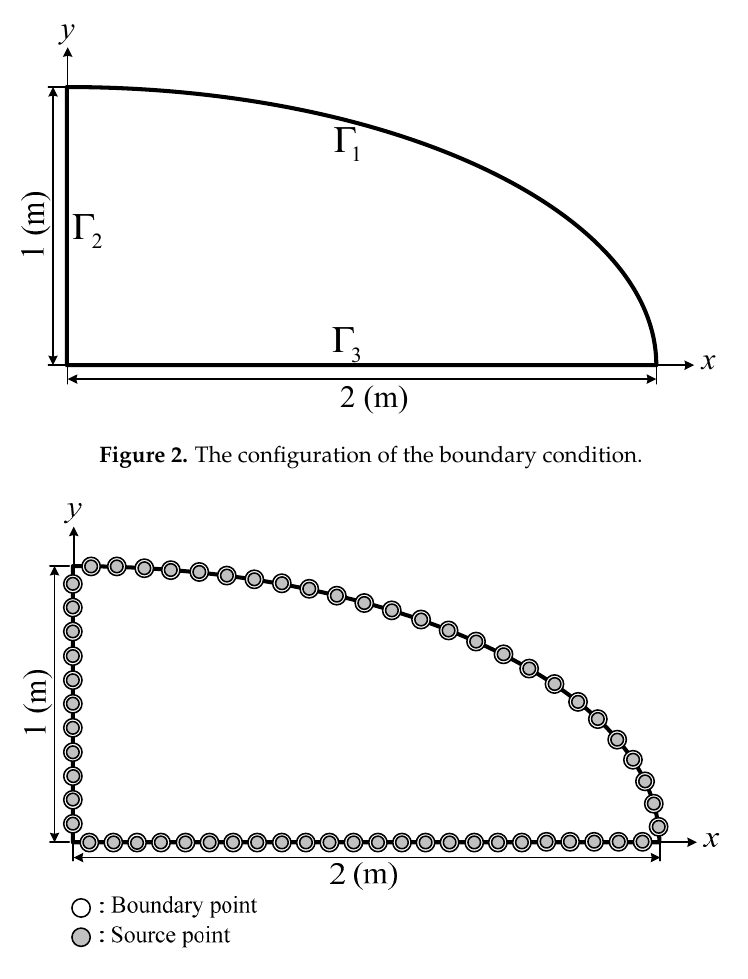
Figure 3. Illustration of collocation points for boundary and source points.